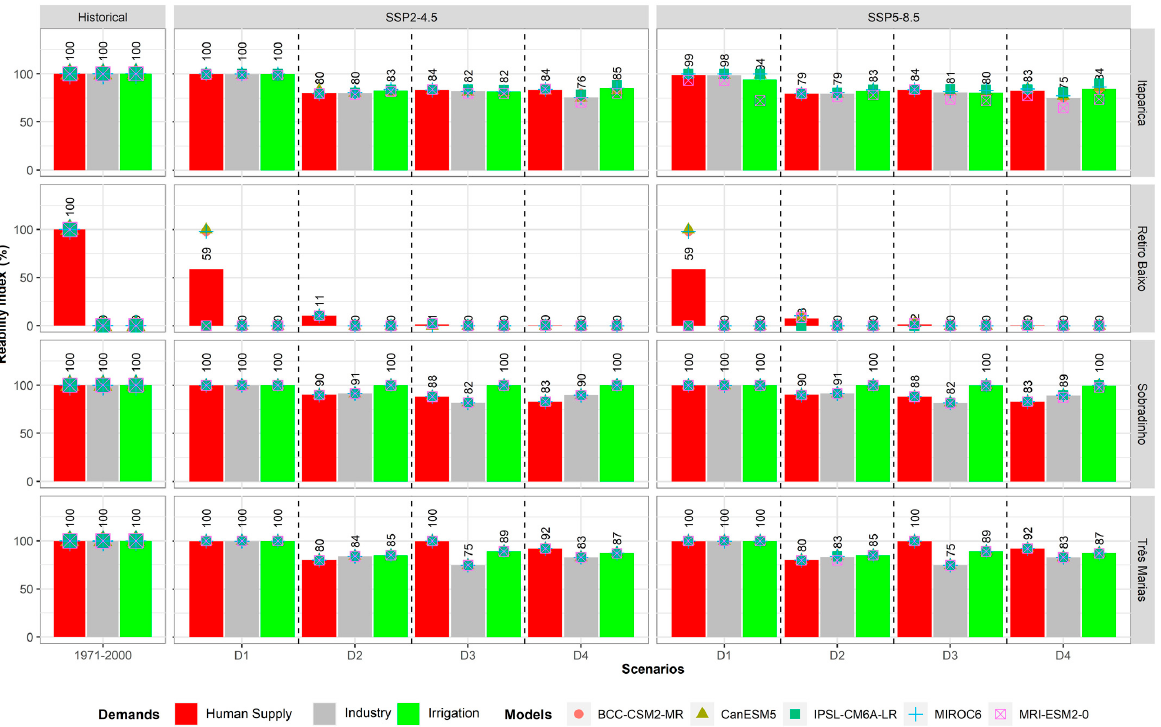
Figure 9. Reliability Index of CMIP6 models for historical period (1971 to 2000), climate change scenarios (SSP2 − 4.5 and SSP5 − 8.5) and consumptive demands projection scenarios (D1, D2, D3 and D4) for SFRB reservoirs. The bars are the averages of the set of models.